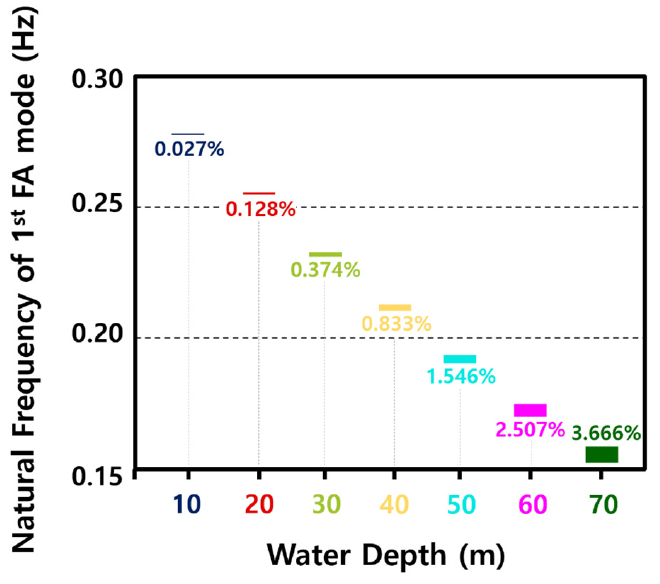
Figure 6. The variable frequency range of 1st fore-aft mode via VNFD.